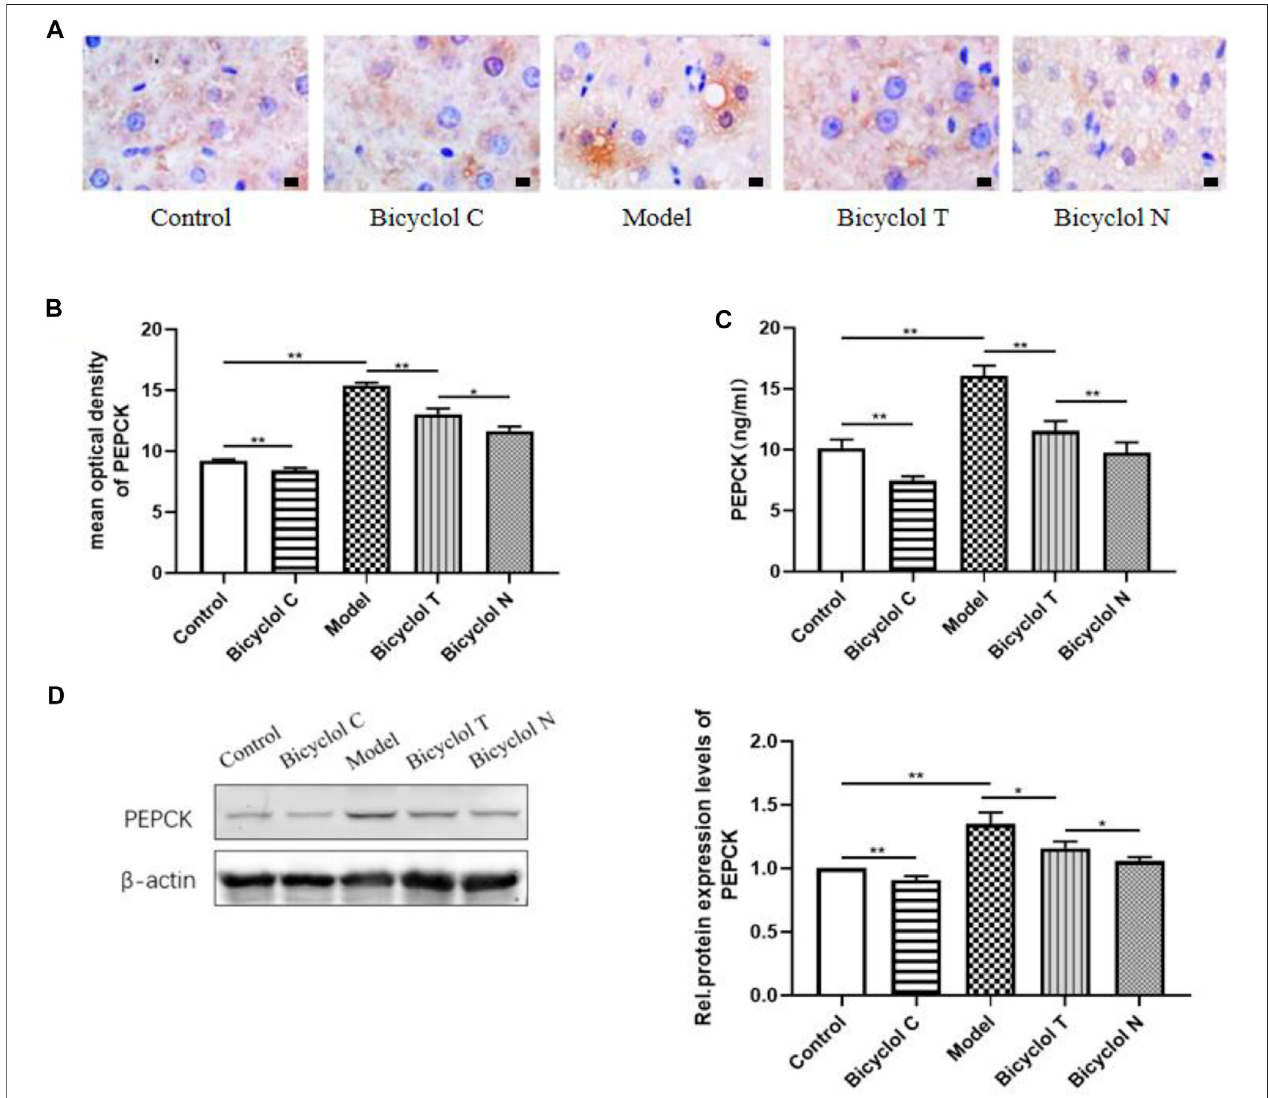
FIGURE7| EffectofbicyclolonPEPCKinT2DMwithNAFLDratserumandliver (A) theexpressionofPEPCKdeterminedbyIHC. (B) Meanopticaldensityanalysis of PEPCK expression in liver. (C) The level of PEPCK in serum. (D) Western blot analysis of PEPCK in liver. Data are presented as means ± SD. * p < 0.05. ** p < 0.01.